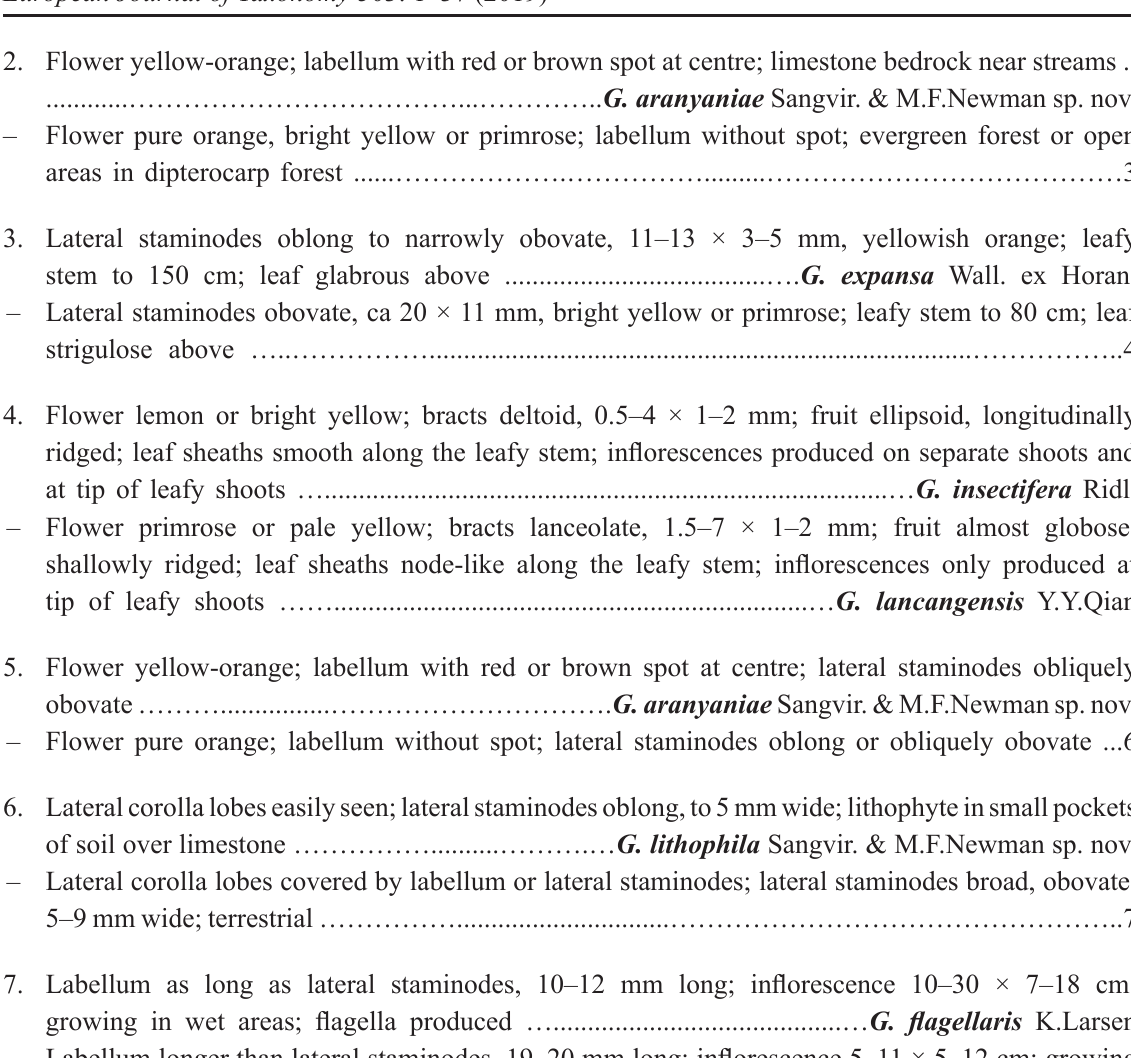
The main distinguishing character within G. subsect. Nudae is the red or brown spot on the labellum. Laotian and northern Thai populations resemble G. flagellaris and G. macrochila sp. nov. by their condensed cincinni, and orange-toned flowers with rather broad lateral staminodes (> 5 mm). Central and eastern Thai populations resemble G. expansa by their lax cincinni, orange-toned flowers, and ellipsoid